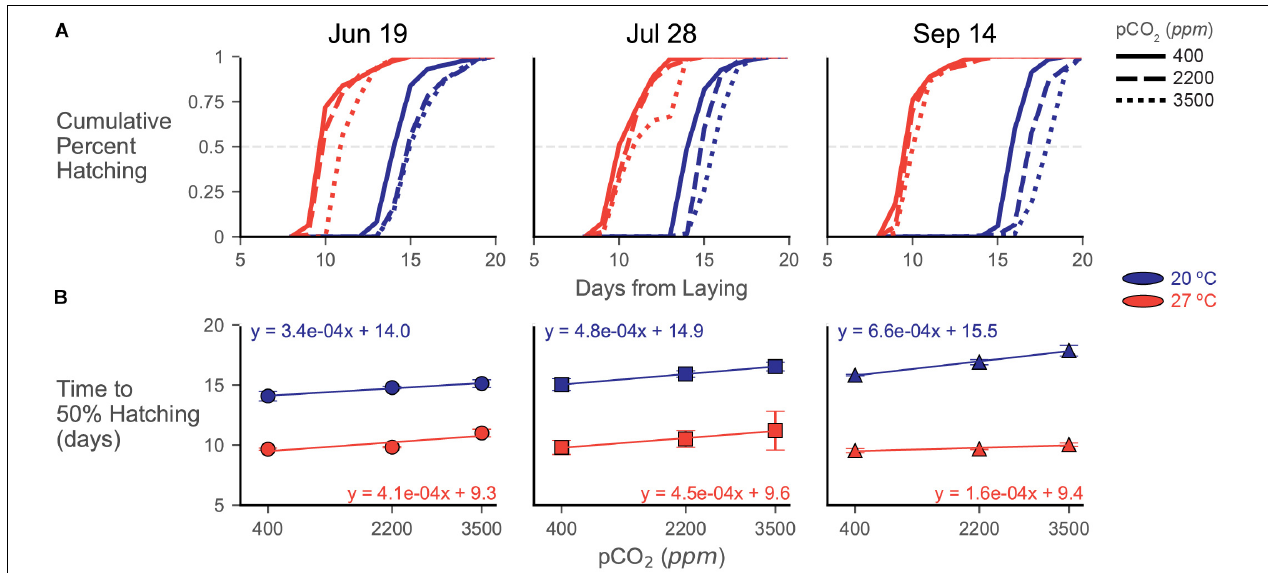
FIGURE 5 | Hatching data from experiments depicted as (A) cumulative hatching curves and (B) plots of time to 50% hatch. (A) Cumulative hatching curves are shown for each trial (lay date in title). Patterning of lines represents acidification treatments (smaller hash = more acidic), while color represents temperature treatment (blue/dark = 20 ◦ C, red/light = 27 ◦ C). Error bars/shading omitted for visual clarity of the curves. The gray dashed line represents the 50% hatching mark. (B) Time to 50% hatching data across acidification exposures, calculated from the curves in (A) , plotted for each trial. Symbols depict means (and represent trial) with errorbars of one standard deviation. Color represents temperature treatment as in (A) . Regression lines with related equations are presented to visualize trends and assess changes in slope and y-intercept across treatments and